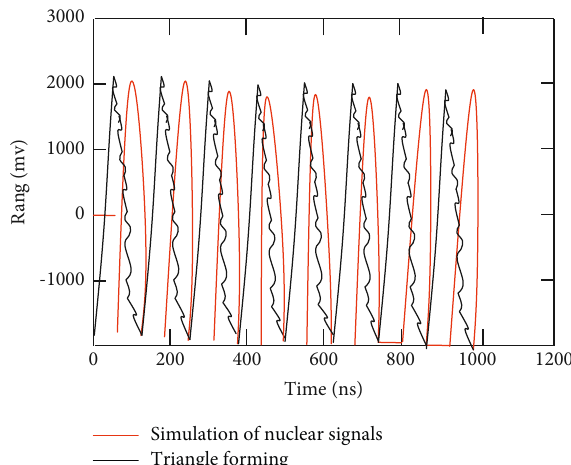
Figure 8: Signal simulation and digital triangulation results of continuous nuclear engineering cost data.